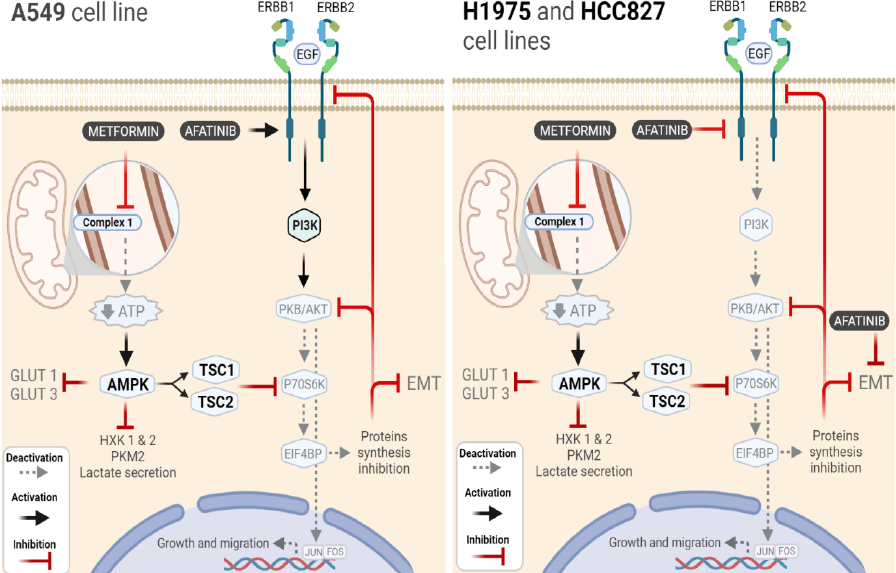
Figure 8. Mechanism of action of combined treatment afatinib–metformin. In the EGFR mutant LC cell lines (H1975 and HCC827), afatinib exerts its basal inhibitory effects over the EGFR pathway, decreasing both processes, glycolysis, and EMT transition. Furthermore, this inhibition can be exacerbated with the complementary effect of metformin through AMPK stimulation and subsequent P70S6K inhibition coupled with a decrease in protein synthesis. On the other hand, the A549 cell line (EGFR wild-type) showed stimulation of the EGFR pathway associated with afatinib treatment as a single drug, however, with complementary metformin treatment, the combination can counteract the pathway activation caused by afatinib, decreasing protein synthesis, glycolytic phenotype, and EMT; also, our results suggest a sensitization of this cell line to afatinib treatment when metformin is added, acting synergistically in cytotoxic induction.